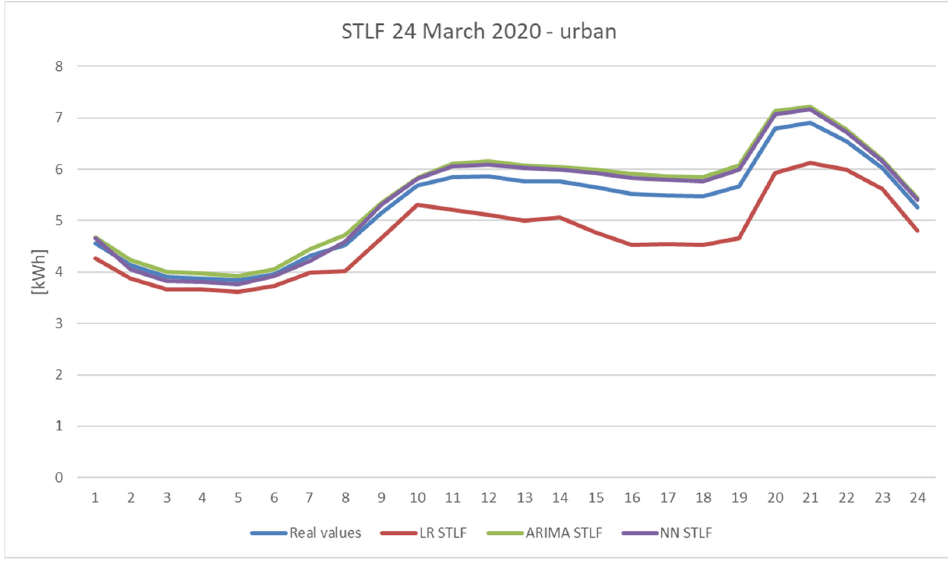
Figure 13. STLF results for 24th March 2020—urban consumers without the adapted algorithm.